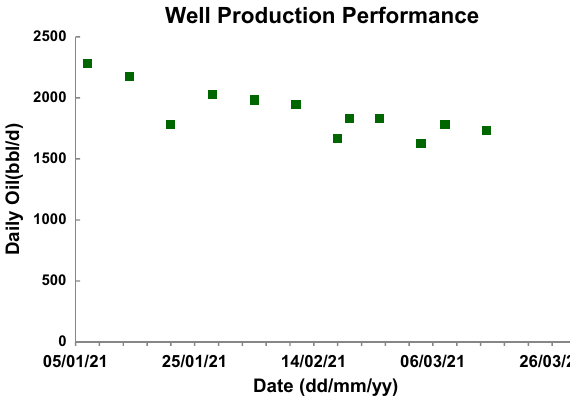
Fig. 27 Daily oil distribution of well